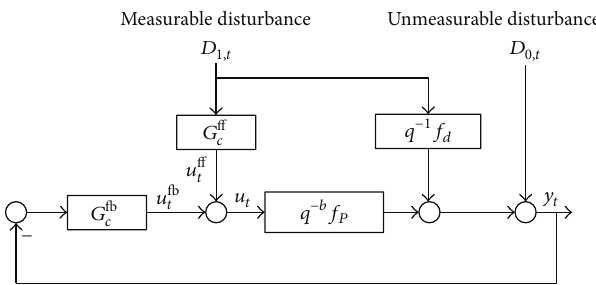
Figure 1: Schematic of feedforward and feedback control